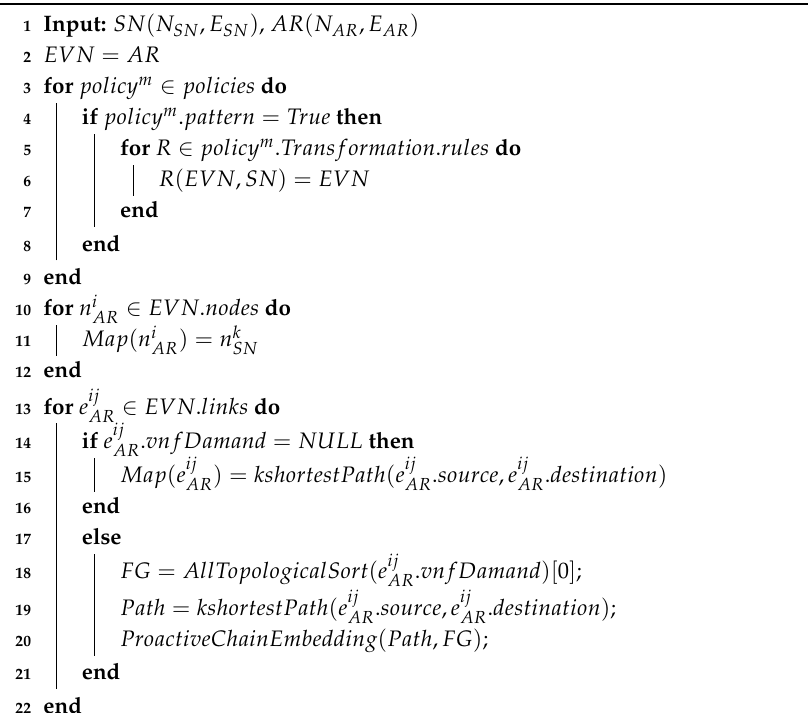
Algorithm 1: System Model